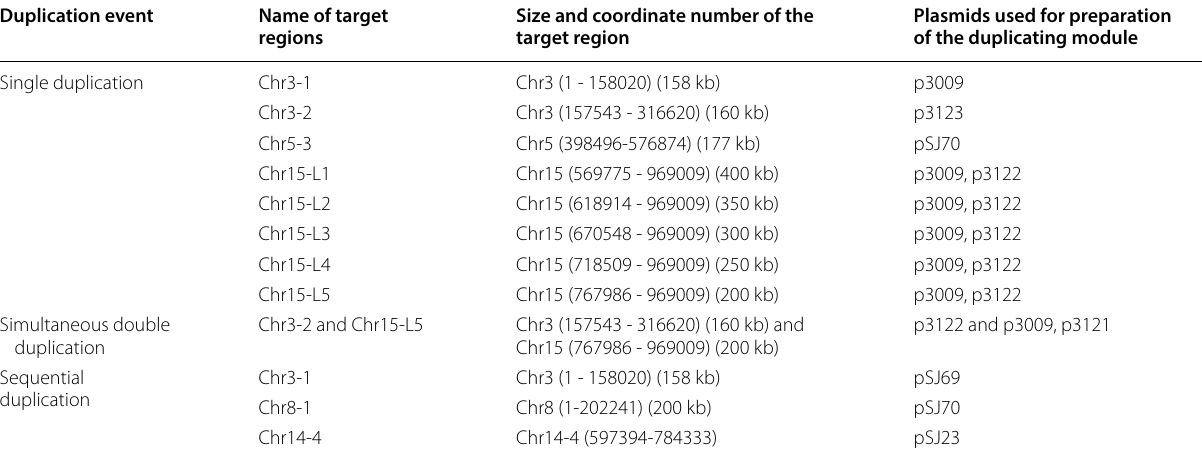
Table 2 Duplication of various chromosomal